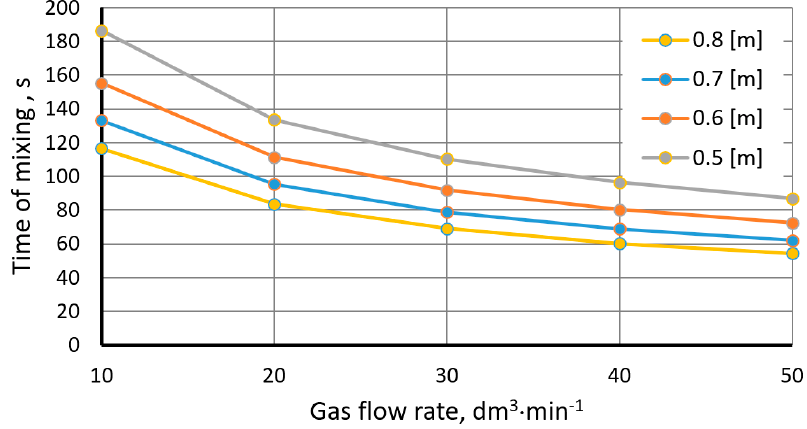
Figure 8. Mixing time as a function of gas flow rate for various heights of the metal column (Iguchi and Nakamura model).